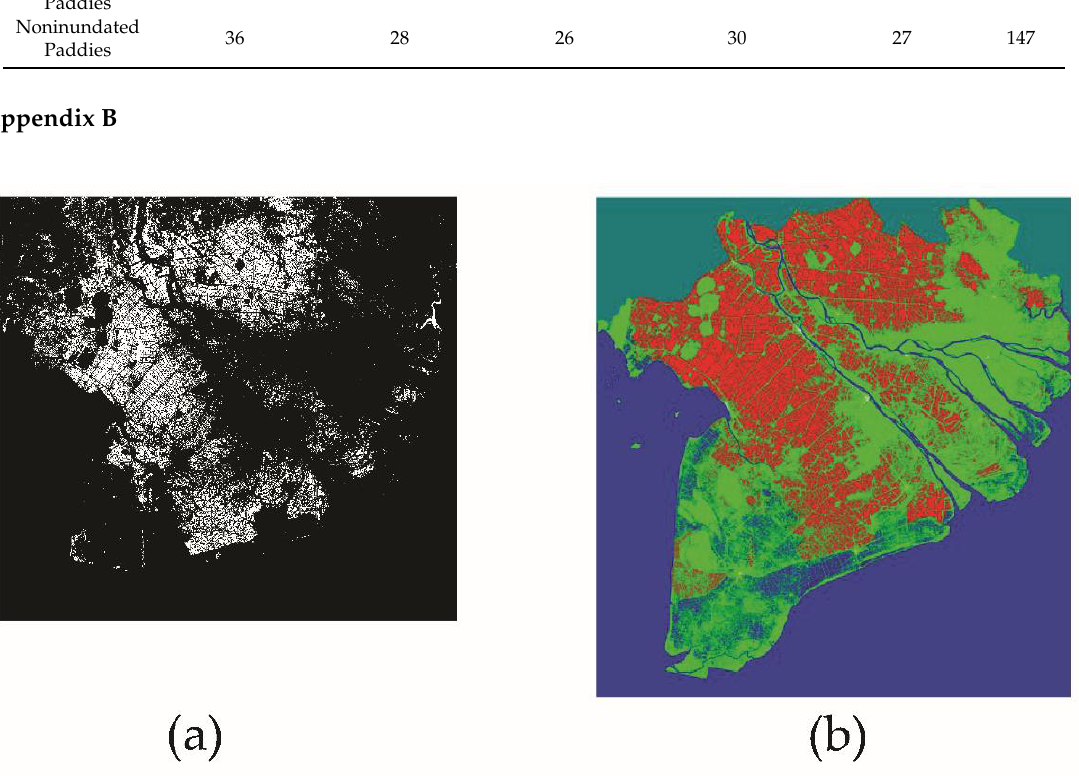
Figure A1. A rice paddy mask for an observation frame computed using PALSAR-2 data (25 scenes) in this study ( a ) and a rice paddy mask computed by Sentinel-1 reported in [18] ( b ). White pixels in ( a ) and red pixels in ( b ) indicate rice paddy pixels.